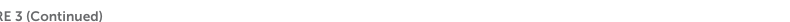
FIGURE3(Continued) filled and the comorbidities examined. For example, the relative rates of GP visits (shaded in blue), was greater in men with MS in the 5 years preceding a 1st demyelinating event than women with MS. † Comorbidities are conditions identified in the 5-years preceding a 1st demyelinating event via validated health administrative algorithms. ‡ Disease and drug classes, specialty visits and comorbidities were compared between MS cases and controls across sex and age groups in the 5 years preceding a 1st demyelinating event. Those that showed significant sex-based differences via likelihood ratio tests or age-based differences via Bonferroni-adjusted tests are